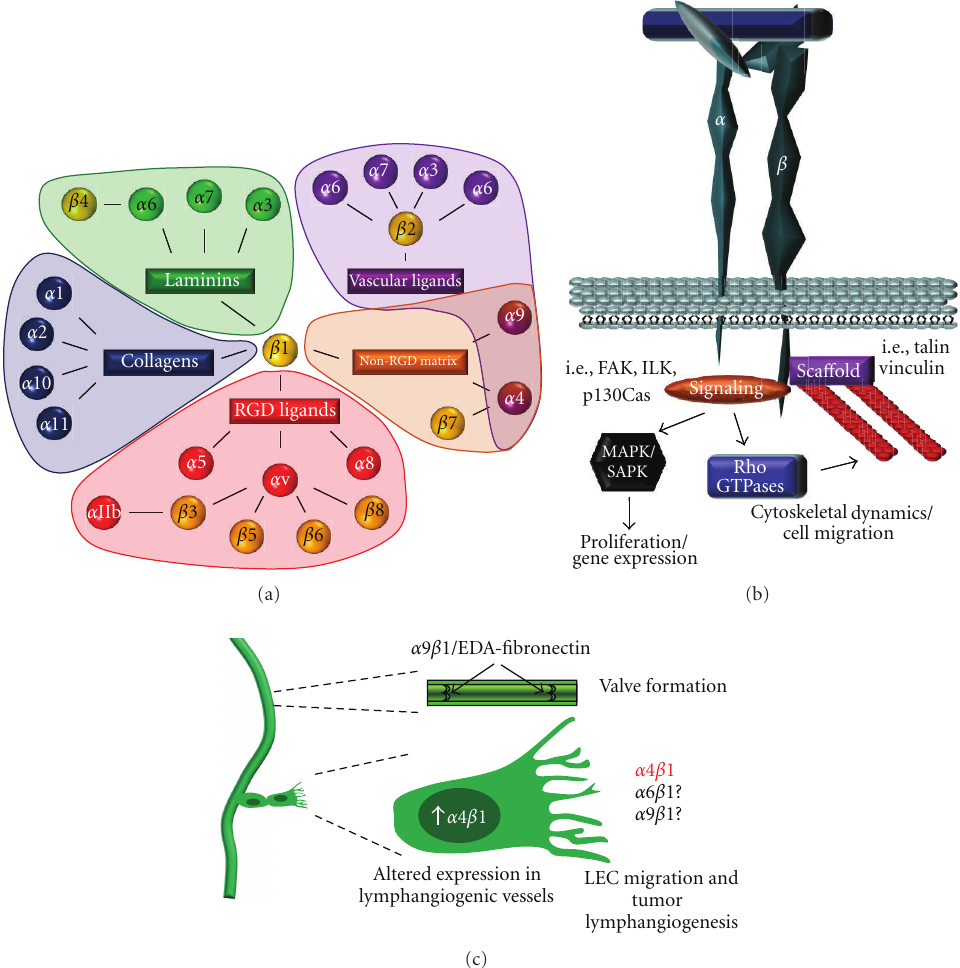
Figure 3: The integrin family of matrix receptors in lymphangiogenesis. (a) Integrin subunits divided by their binding partners (connecting lines) and ligand-binding preferences (shaded areas). (b) Structure of integrin adhesions. Integrins link the extracellular matrix to the intracellular actin cytoskeleton through structural adaptor proteins. Recruitment of signaling proteins activates pathways that regulate gene expression (e.g., MAP kinases) and cytoskeletal reorganization (Rho GTPases). (c) Expression of the integrin α 9 β 1 and its EDA-fibronectin ligand are required for proper lymphatic valve development. While α 6 β 1 and α 9 β 1 are implicated in tumor angiogenesis, only α 4 β 1 has been shown to be upregulated in lymphangiogenic vessels, to mediate LEC migration and tube formation in culture, and to be required for tumor-associated